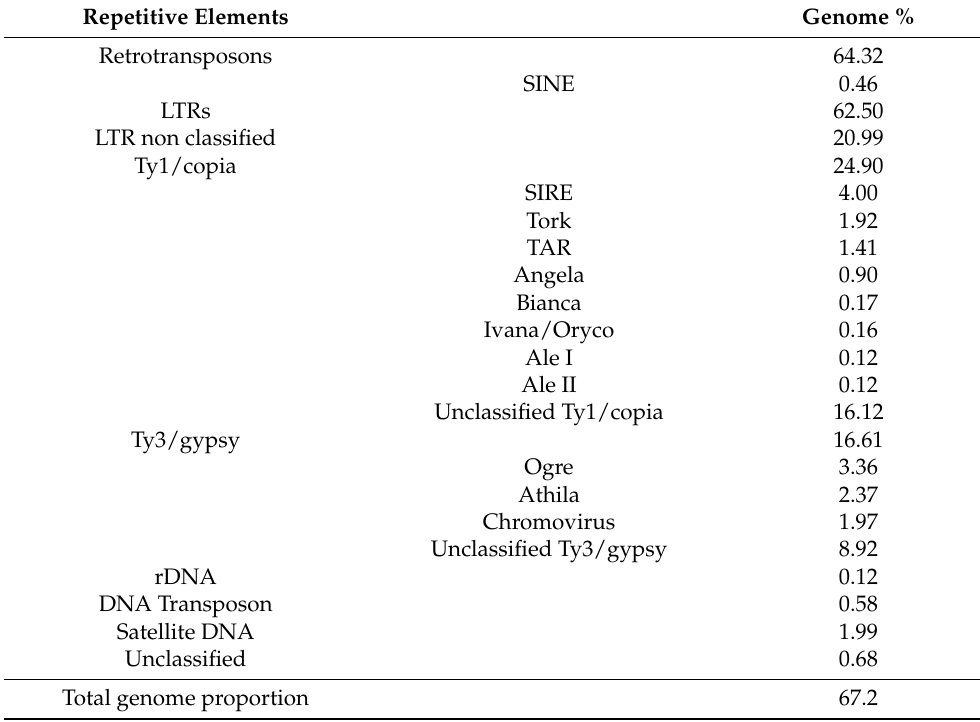
Table 1. Genome proportion of major repetitive elements of the Agave hybrid